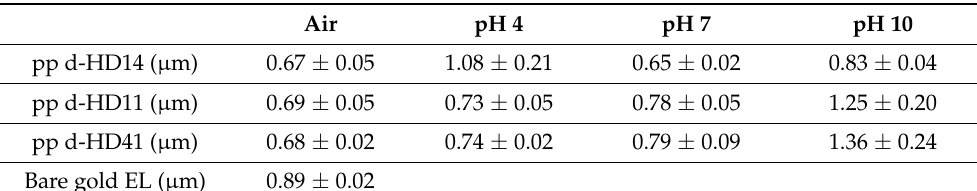
Figure 8. ( A – I ): AFM images and the corresponding height profiles of the plasma-polymerized hydrogel coatings (d-HD14, d-HD11, and d-HD41) in acidic (pH 4) ( A – C ), neutral (pH7) ( D – F ), and alkaline (pH 10) ( G – I ) solutions. White lines indicate the location of the height profile. AFM images of the coatings in air and a bare gold electrode are shown in Figures S9 and S10. Table 3. Root mean square surface roughness (RMS) of hydrogels in air and in different buffer solutions. ( n =